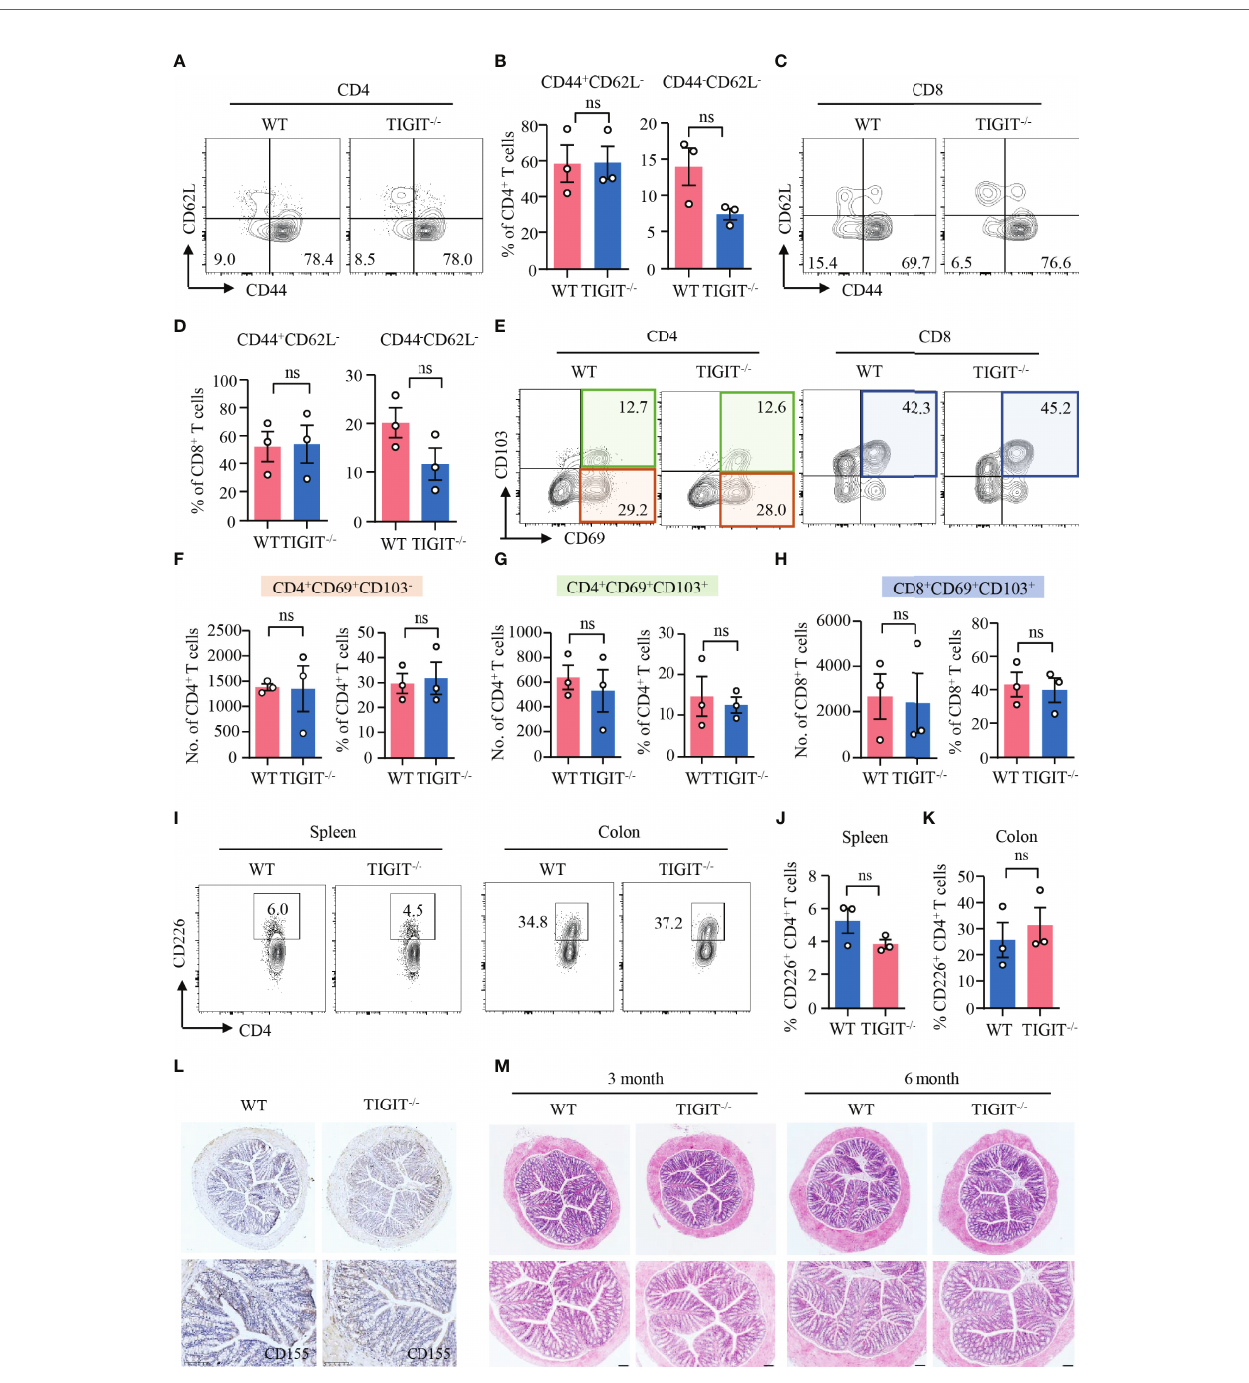
FIGURE 4 | TIGIT de fi ciency neither affected T-cell residency nor induced spontaneous autoimmune response in the gut. Colons were collected from TIGIT − / − or WT mice of 8 weeks old and LPMC were isolated for fl ow cytometry. (A – D) CD44 and CD62L expression in CD4 + and CD8 + T cells was measured by fl ow cytometry. Representative counter plots were shown. The percentages of CD44 + CD62 − or CD44 − CD62L − in CD4 + and CD8 + T cells were summarized from three independent mice. (E – H) CD103 and CD69 expression in CD4 + or CD8 + T cells from LPMC was measured by fl ow cytometry. Representative counter plots were shown and data were from three independent mice. (I) Representative counter plots of CD226 expression in CD4 + T cells from the spleen or LPMC. (J, K) Frequencies of CD226 + CD4 + T cells from spleen or colon were summarized. (L) CD155 expression in the colon was measured by immunohistochemistry. Representative images were shown. Original magni fi cation: ×10. (M) Colons from WT and TIGIT − / − mice embedded with paraf fi n were sectioned and stained with H&E. Representative images were shown. Original magni fi cation: ×4 (top), ×10 (bottom). ns, not signi fi